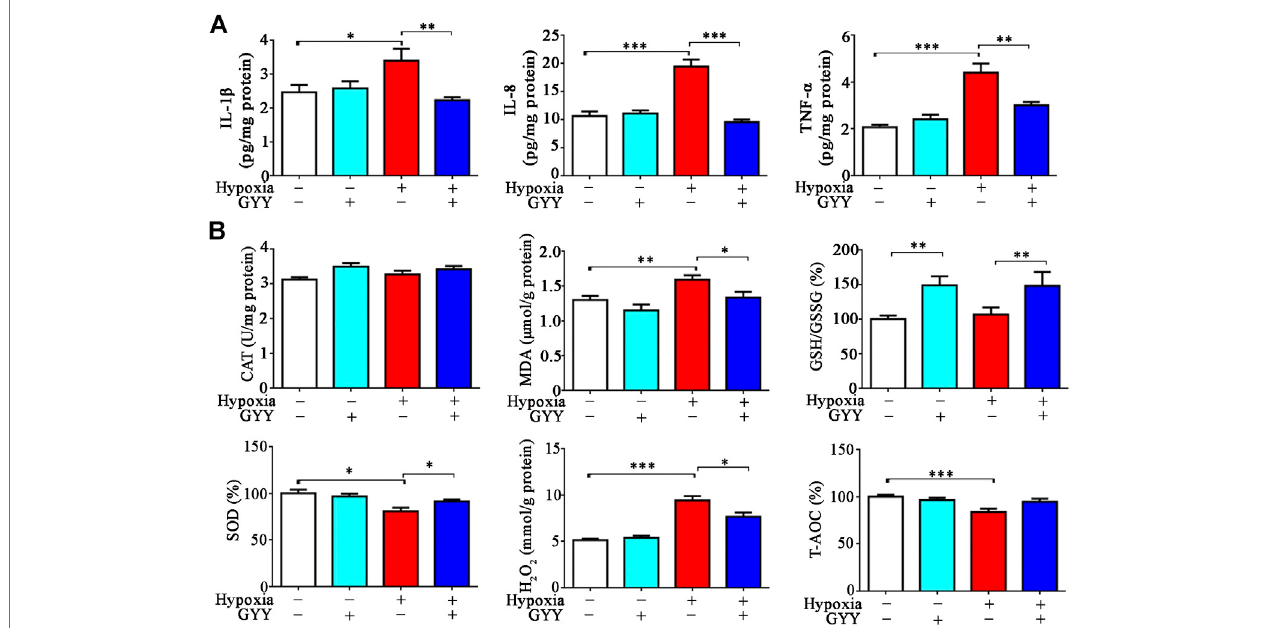
FIGURE 8 | GYY4137 treatment reduces the levels of proin fl ammatory cytokines and improves oxidative stress in lung tissues of the mice with hypoxia insult. H 2 S alleviateshypoxia-inducedin fl ammationandoxidativestressinthelungs.MiceweretreatedwithGYY4137(50mg/kg)andimmediatelysubjectedtonormobarichypoxia for24h.Micewerethensacri fi ced,andlungstissueswerecollectedfordeterminationofproin fl ammatorycytokinelevelsandoxidativestressparameters. (A) ,IL-8,IL-1 β , andTNF- α levelsinlungtissues. (B) ,GSH/GSSG,CAT,SOD,H 2 O 2 andT-AOCinlungtissues.Dataareexpressedasmean ± SEM; n (cid:2) 8 – 11pergroup;* p < 0.05, ** p < 0.01, *** p <